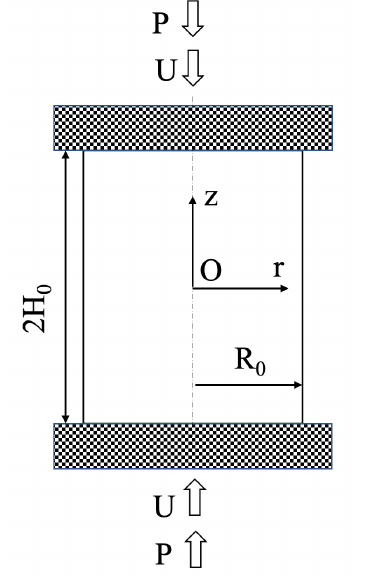
Figure 1. Schematic of the upsetting of a